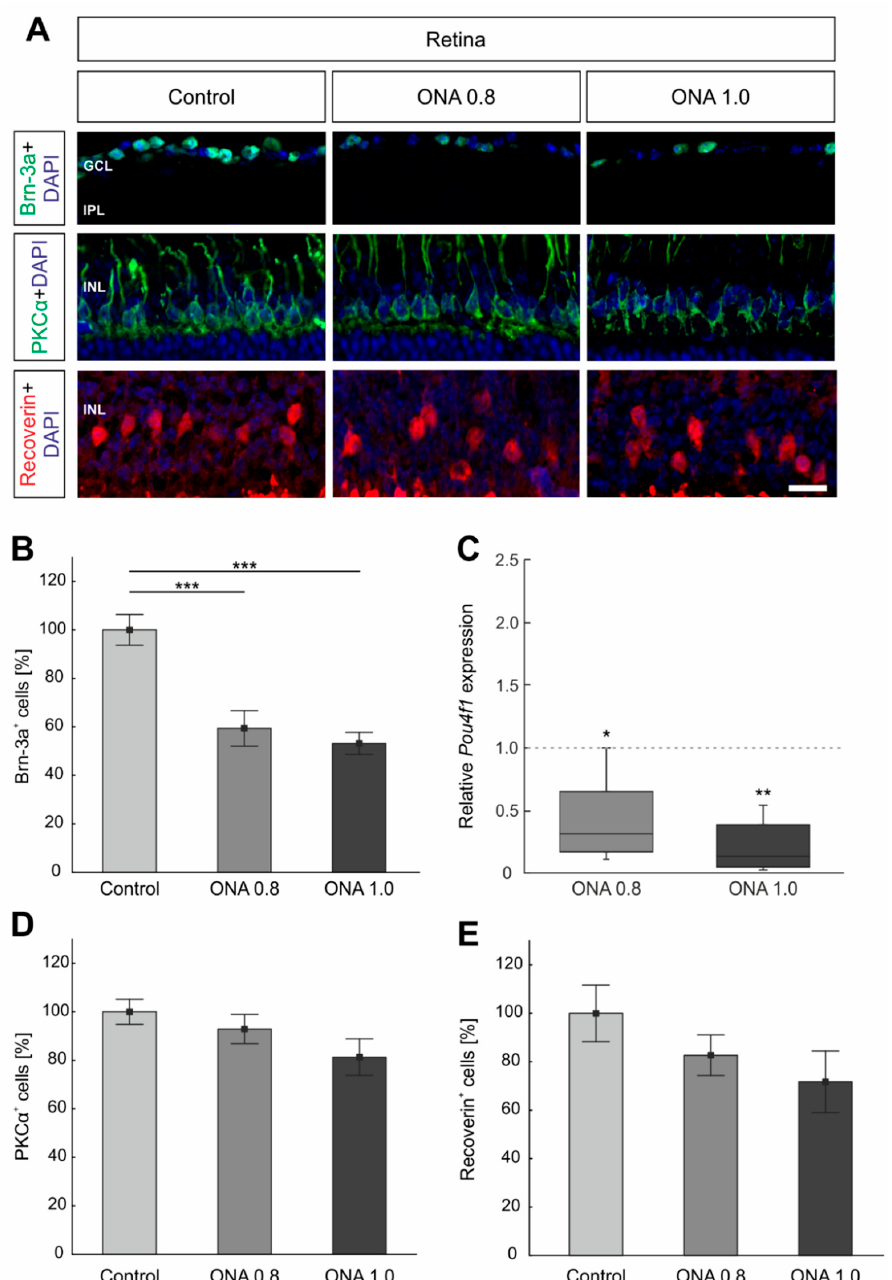
Figure 1. Loss of retinal ganglion cells. ( A ) Retinal cross-sections were stained with antibodies against anti-Brn-3a (retinal ganglion cells—RGCs; green), anti-PKC α (rod bipolar cells; green), and anti-recoverin (cone bipolar cell; red). Cell nuclei were labeled with DAPI (blue). ( B ) The number of Brn-3a + cells was significantly reduced in optic nerve antigen homogenate (ONA) 0.8 and ONA 1.0 animals (both: p < 0.001) compared to the control group. ( C ) Additionally, the mRNA expression of Pou4f1 showed a significant downregulation in ONA 0.8 ( p = 0.02) and ONA 1.0 retinas ( p = 0.008). ( D ) Regarding PKC α + cells, no changes could be noted in both immunized groups compared to controls ( p > 0.05). ( E ) Also, the number of recoverin + cells remained unaltered ( p > 0.05). Abbreviations: GCL = ganglion cell layer, IPL = inner plexiform layer, INL = inner nuclear layer. The dotted line in C represents the relative expression level of the control group. Values are mean ± SEM for immunohistology and median ± quartile + maximum/minimum for RT-qPCR. Scale bar: 20 µm. * p < 0.05, ** p < 0.01, *** p < 0.001.